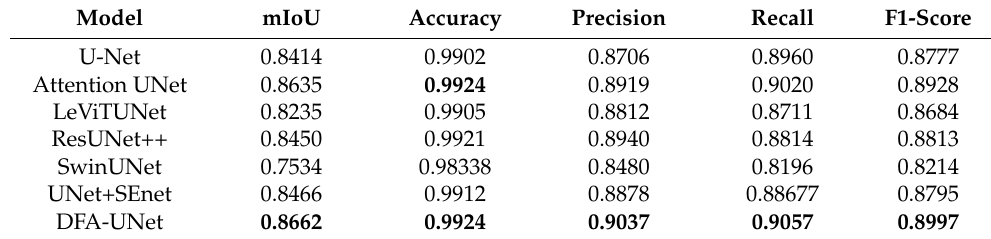
Figure 4. MIoU performance on different models .